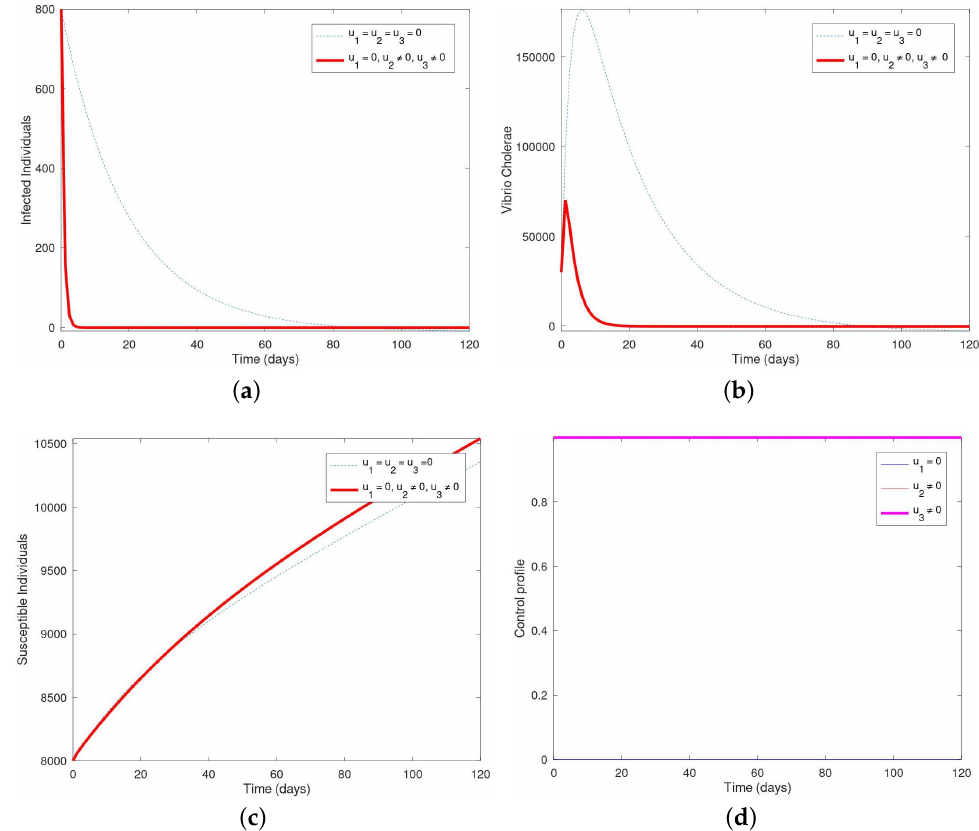
Figure 6. Simulation showing the population of ( a ) infected, ( b ) vibrio cholerae, ( c ) susceptible and ( d ) the control profile with ( u 2 , u 3 ) . In Figure 6a, the population of infected humans decreases within the first 2 days and then decreases until it vanishes completely from the system within 20–120 days. Figure 6b shows that the population of vibrio cholerae increases within the first 2 days and then decreases until it vanishes completely from the system within 20–120 days. In Figure 6c, the susceptible human population inctreases over the time period in the presence of the control intervention but was much slower within the control intervention. In Figure 6d, the control profile shows that the control ( u 2 ), and ( u 3 ) remained constant from day 1 till the end of the 120 days while ( u 1 ) maintained lower